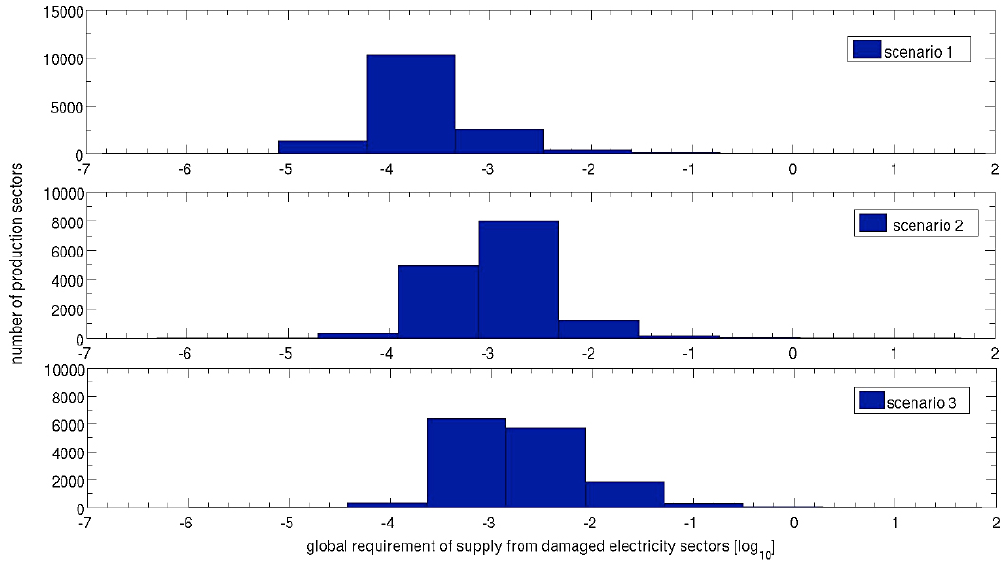
Figure 2. Global production requirement of supply from damaged electriciy sectors. The treshold for scenario 1 is 2 × 10 − 5 , for scenario 2 5 × 10 − 5 , and for scenario 3 1 × 10 − 6